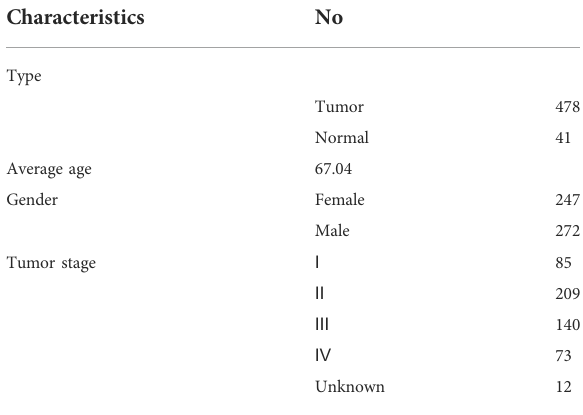
TABLE 1 General clinical information of CRC patients included in this study.